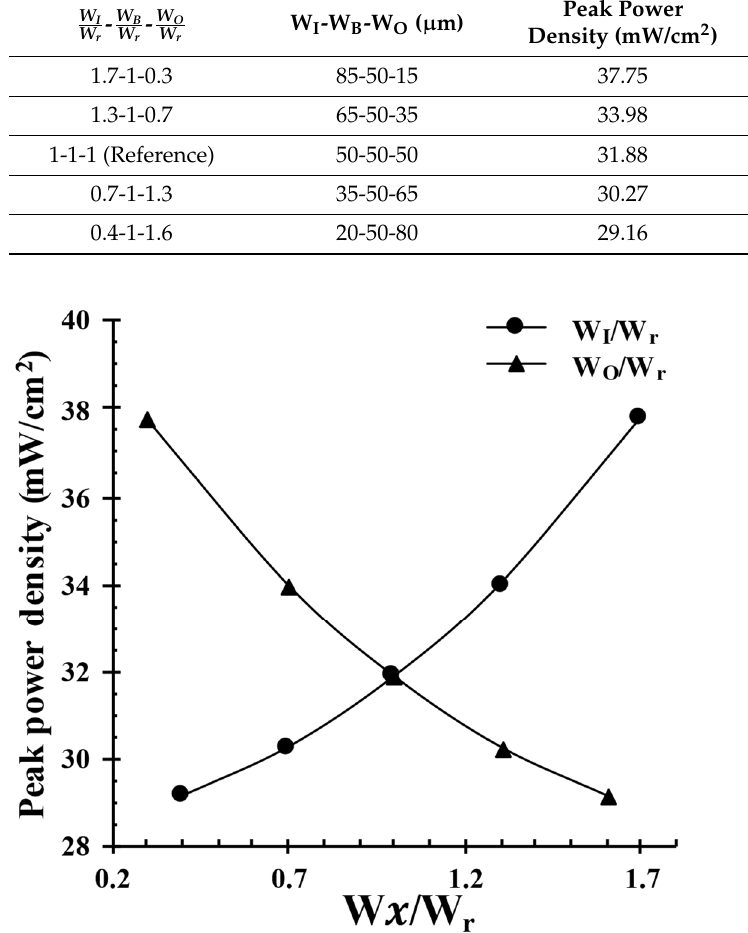
Figure 2. Variations of peak power density with W I and W O for fixed W and W B (W B /W r = 1.0).